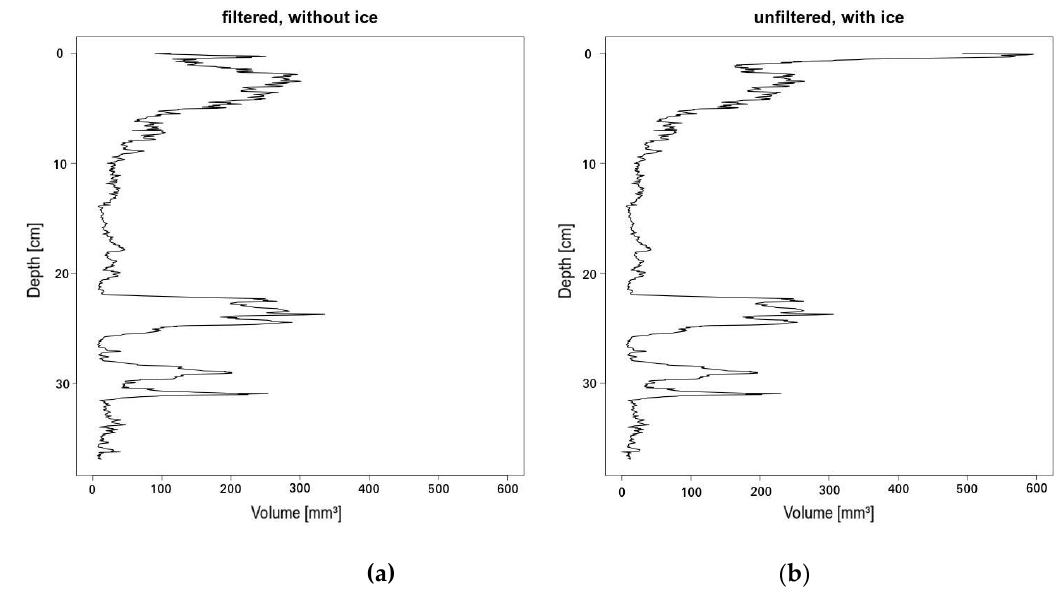
Figure 9. Volume per slice (0.48 mm) for the 3D model of RWSS as measured in Fiji. ( a ) Size filtered model without ice. ( b ) Unfiltered model with ice.